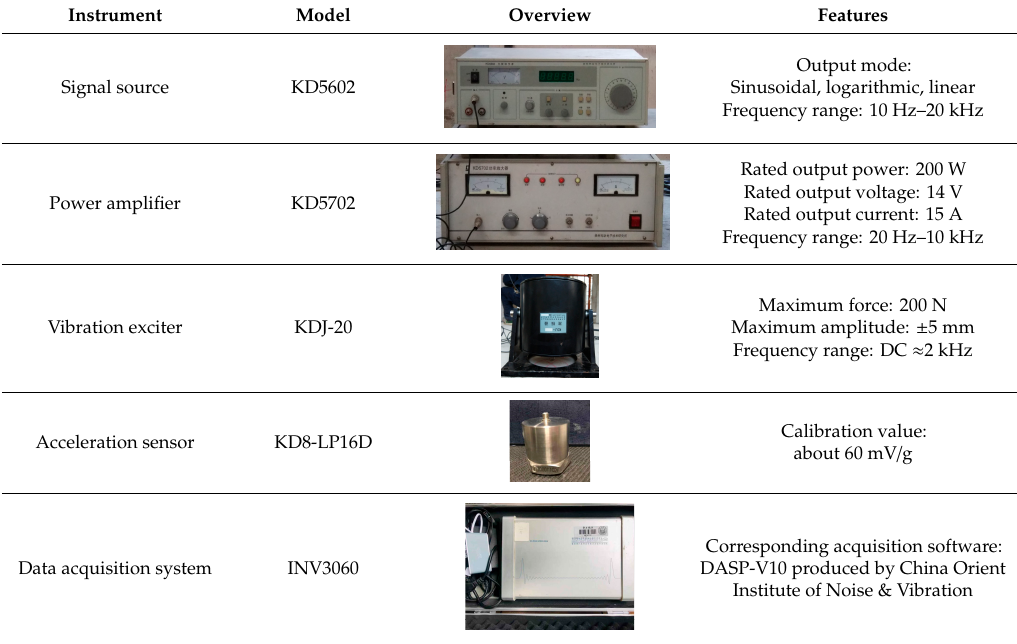
Table 9. Instrument parameters.